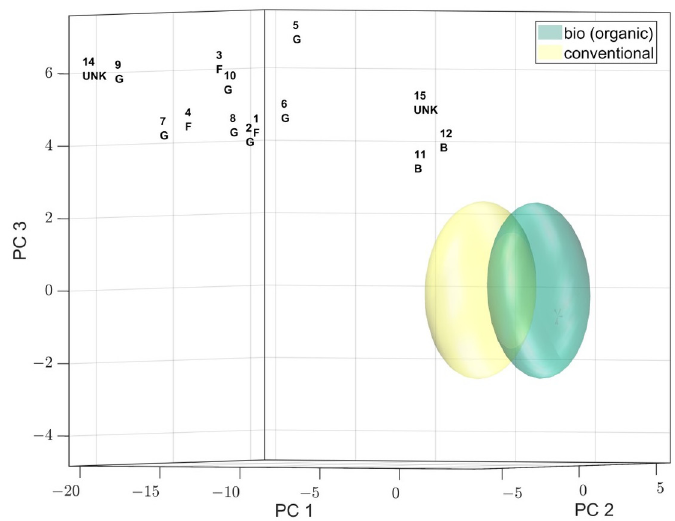
Figure 1. Score plot of egg samples (untreated (D 1 )chloroform was used) with very conspicuous sample scores having a very large offset. Sample scores labelled “B” (B for bio, i.e., organic farming) should be in or close to the green right confidence ellipsoid, sample scores labelled “F” or “G” are expected close to or in the left, yellow cloud (F for free range, G for ground; UNK for unknown, i.e., undeclared